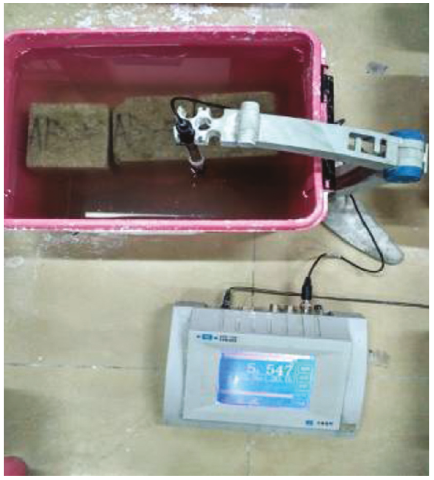
Figure 2: DZS-708